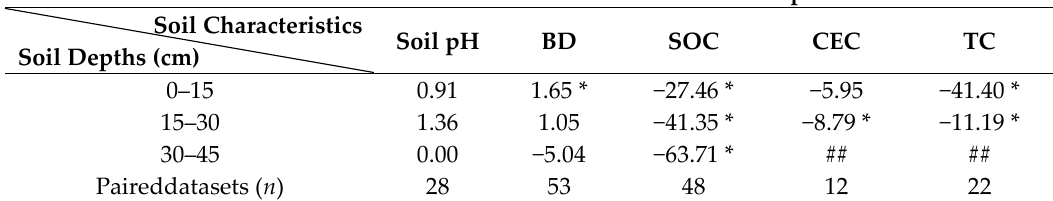
Table 4. Percent mean effect of grassland compared to forestland on soil characteristics at various depths in India.